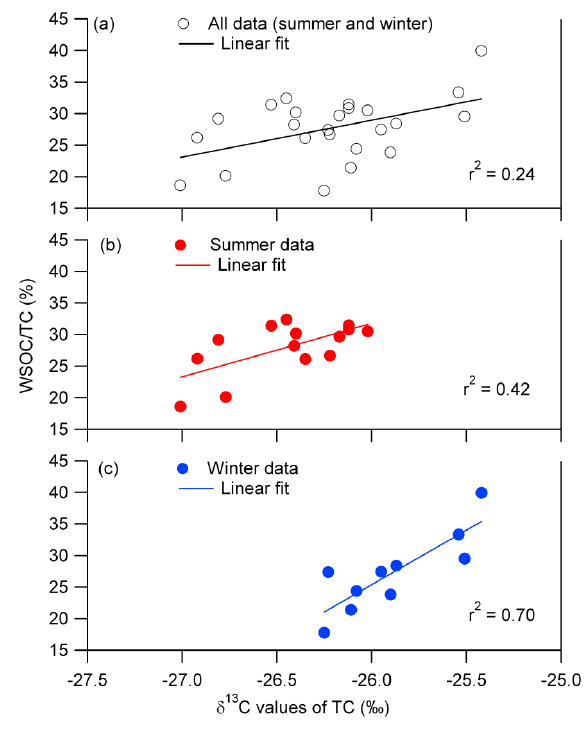
Fig. 11. Relation between WSOC/TC ratios and δ 13 C values of TC in (a) both seasons, (b) the summer season, and (c) the winter sea-